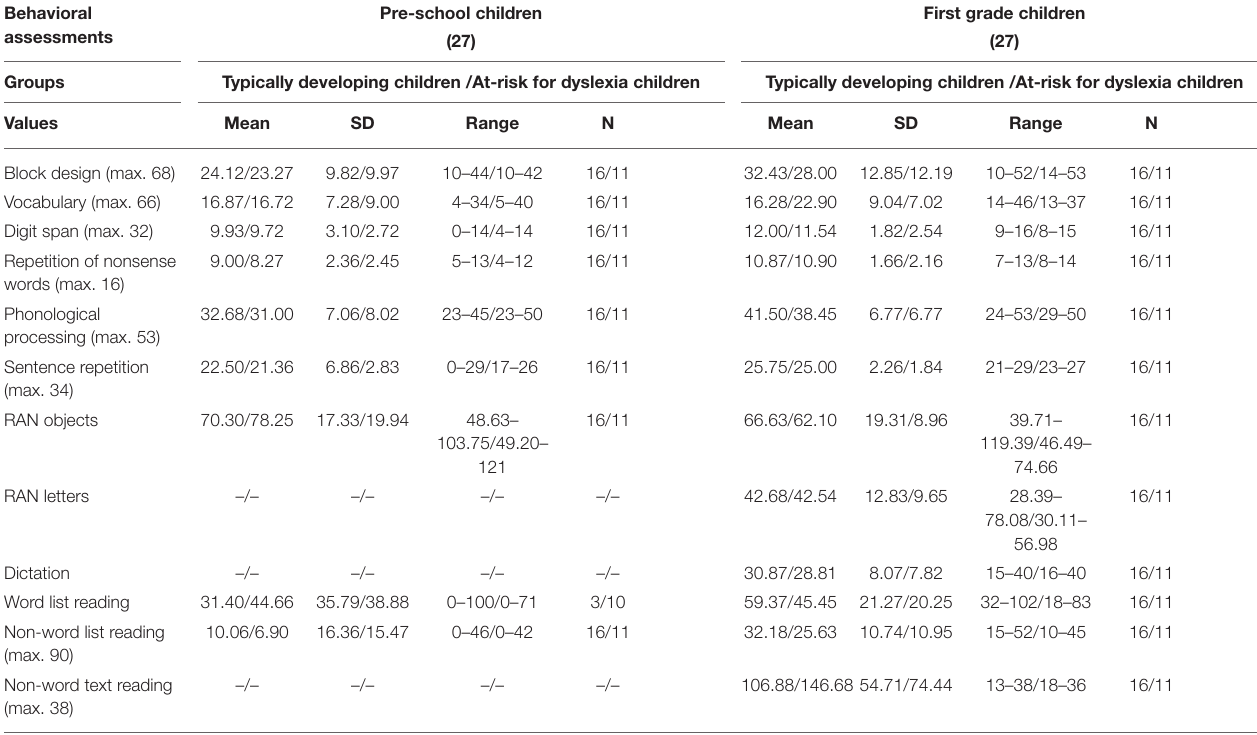
TABLE 2 | Descriptive statistics of the participants’ cognitive skill measures ( N = 16 pre-school and first grade typically developing children, N = 11 pre-school and first grade at-risk for dyslexia children, separated by